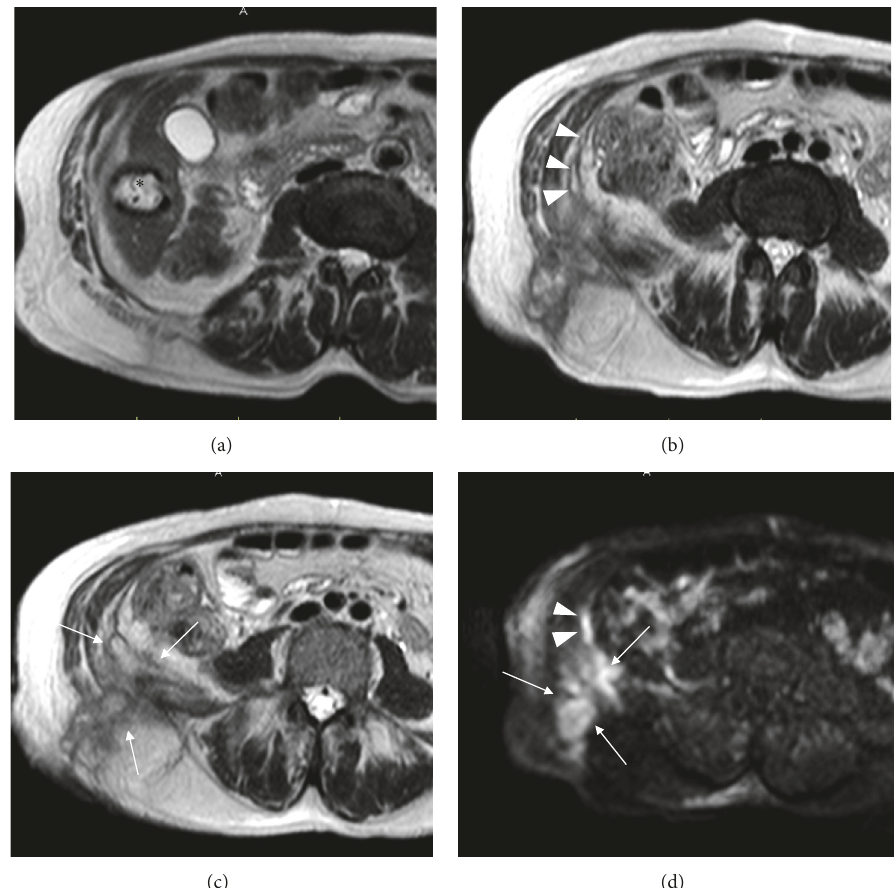
Figure 2: Axial MR TSE T2-weighted scans (a–c) show the hydatid cyst (asterisk) , with a soft hyperintensity of the surrounding hepatic parenchyma due to inflammation, the fistulous tract (arrowheads) , and the abdominal-subcutaneous abscess (arrows) involving the right iliac muscle. Axial diffusion weighted image ( 𝑏 - value 800 s/mm 2 ) (d) demonstrates the high hyperintensity of both the abscess (arrows) and the fistula (arrowheads) .